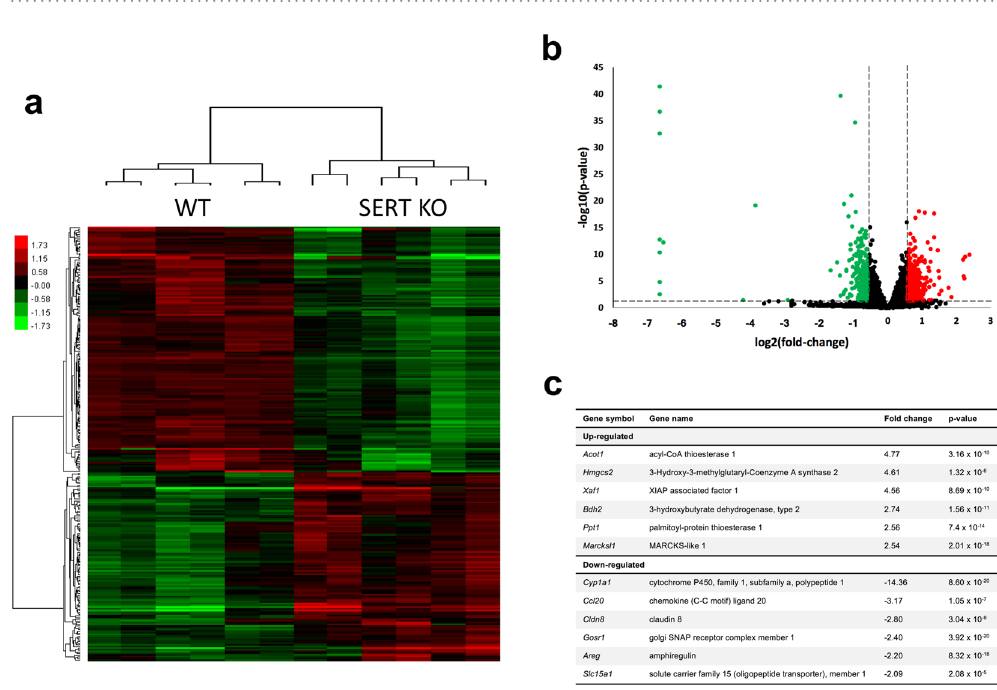
Figure 6. Microarray gene expression analysis of SERT KO ileal mucosa. Gene expression in the ileal mucosa of 6 WT and 6 SERT KO mice was analyzed by microarray analysis as described in Methods. ( a ) Heat map showing the result of unsupervised hierarchical clustering of selected differentially expressed genes between WT and SERT KO. ( b ) Volcano plot showing the distribution of differentially expressed genes with cutoff criteria of log2|fold-change| ≥ 0.585 and a p-value < 0.05. Up-regulated genes shown in red and down-regulated genes shown in green. ( c ) List of selected genes that were significantly up-regulated or down-regulated in SERT KO mouse ileal mucosa. Full list of differentially expressed genes available at GEO (accession